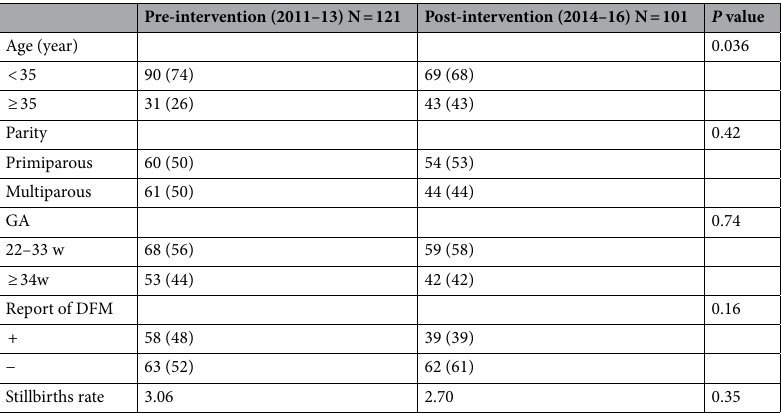
Table 1. Descriptive characteristics of total stillbirths in this study. GA gestational age, DFM decreased fetal movement. Stillbirths rate indicates per 1000births. Data are n